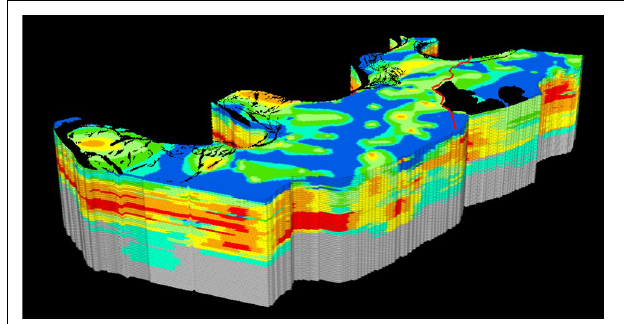
FIGURE 12 | 3-D Geologic Model showcasing distribution of Quaternary alluvium under Lake County, Tennessee. Red is sandy gravel, orange is sand, yellow is silty sand or clayey sand, light green is an unknown mix with percentages of clay, silt, and sand, green is silt, light blue is clayey silt or silty clay, and blue is clay. Gray represents Eocene. Reelfoot Lake and the Mississippi River are black. Red line illustrates the location of the surficial Reelfoot scarp. Vertical exaggeration = 25. Animation in Supplementary Appendix A .